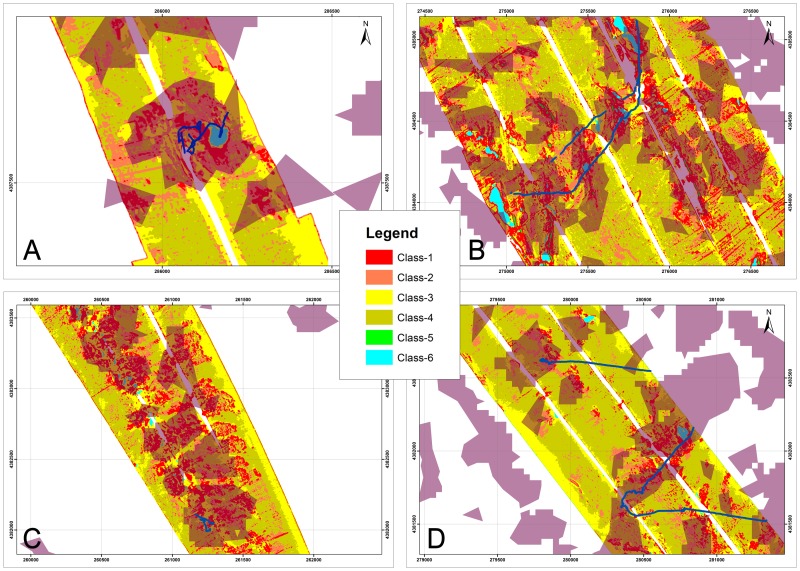
A: Details of the classified results of the SSS mosaic at sites (A) MS04, (B) MS06, (C) MS08, and (D) ReefABC. See Figures 2 and 3 for location. In A, B, and C the blue line indicates the MGS video survey tracks and the polygons in violet indicate boundaries of mound areas. In D the blue line indicates the QUEST4000 ROV-video survey track and the polygons in violet indicate the boundaries of mound areas.